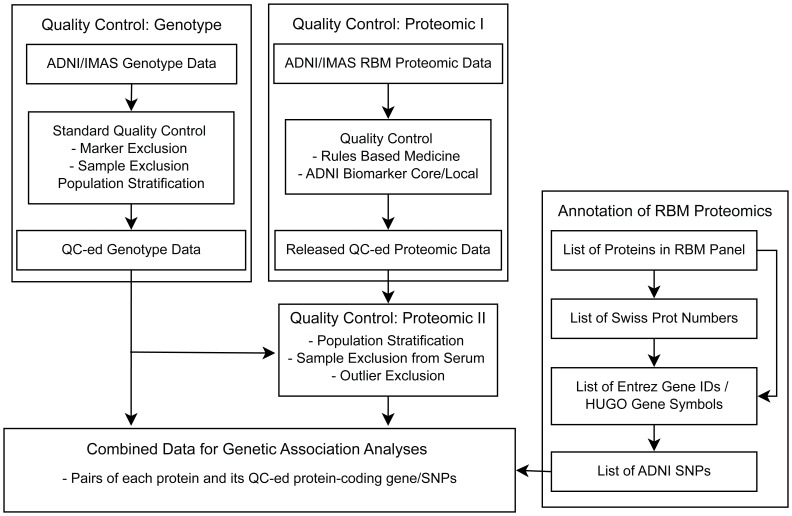
Quality control procedure for genetic and proteomic data.